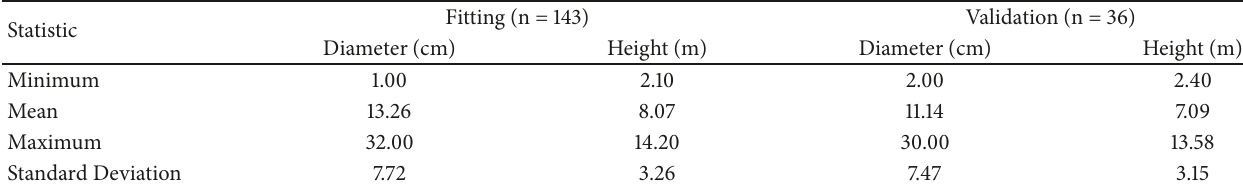
Table 1: Descriptive statistics of the variables for both fitting and validation dataset.